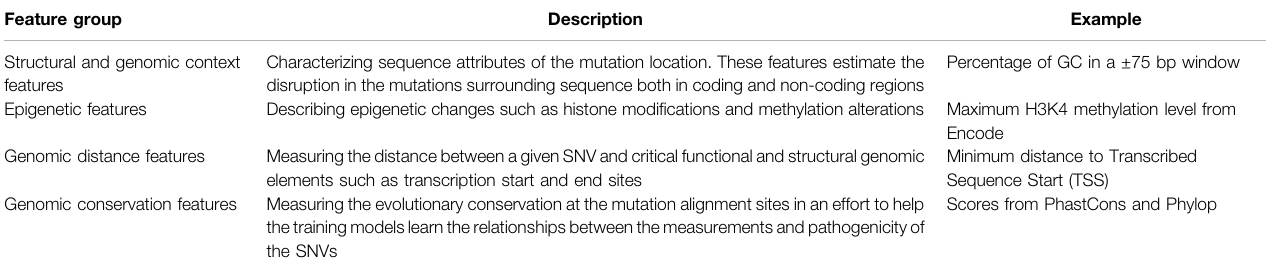
TABLE 1 | Four major genomic feature groups characterizing the SNVs in gold standard datasets. Feature